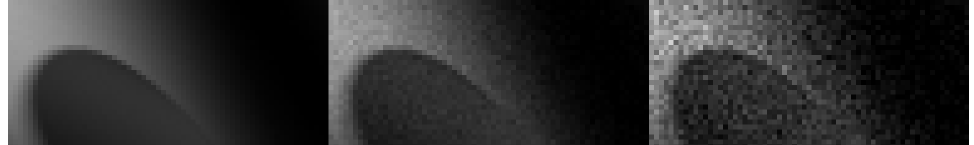
Figure 2. Crop of image shown with varying levels of noise. From left to right: k = 1, k = 10 2 , k = 10 3